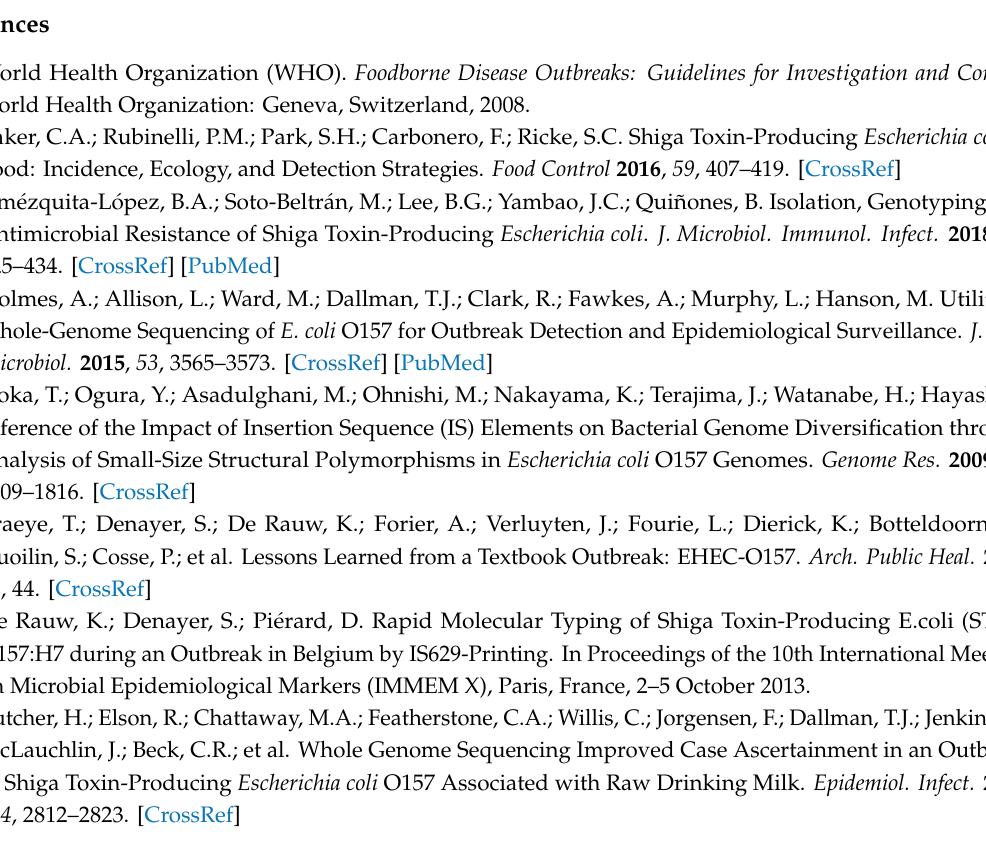
Table S1: Characteristics of all background isolates determined with conventional methods and WGS, Table S2: WGS-based serotype determination, Table S3: WGS-based virulence allele typing, Table S4: NCBI SRA accession numbers of WGS data of all isolates, Figure S1: Conventional typing results of the Limburg 2012 outbreak, Methods: Conventional ISO workflows for STEC detection, isolation and identification from food samples, as performed during the initial outbreak